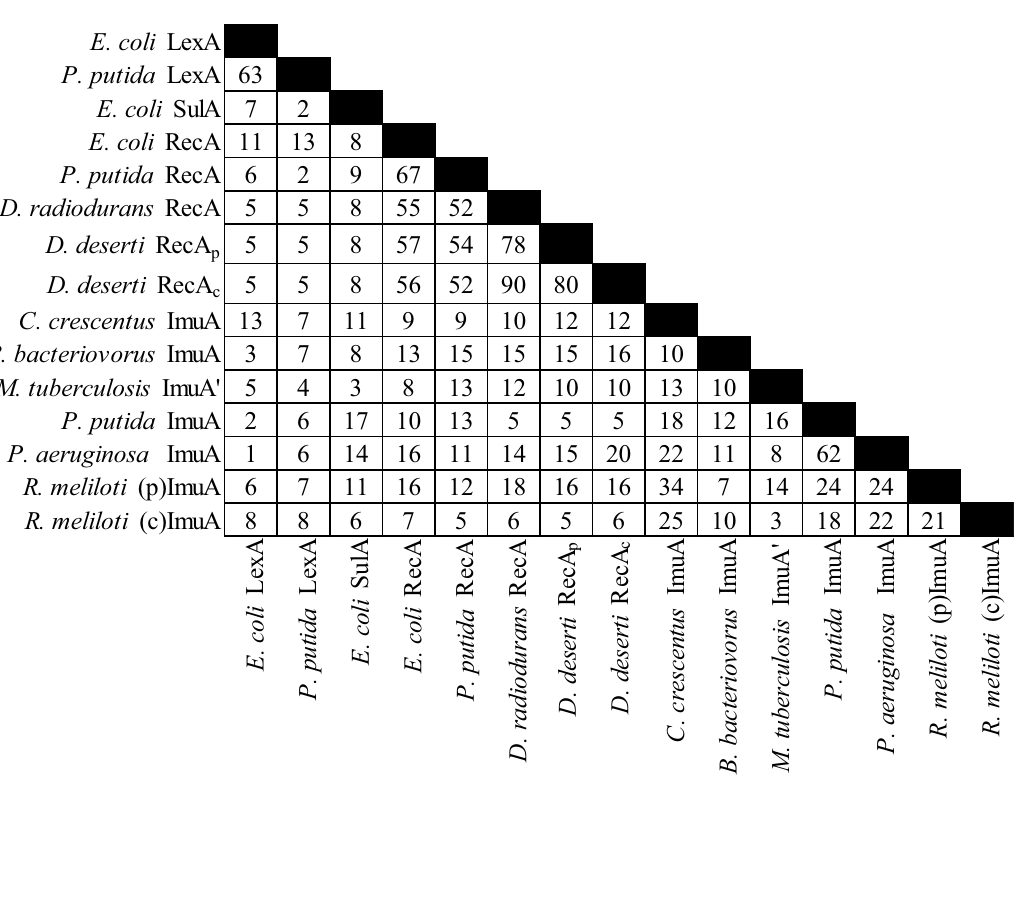
Figure 2. Percent identities by ClustalW2 [213,214] for the ImuA protein and related (cid:83)(cid:85)(cid:82)(cid:87)(cid:72)(cid:76)(cid:81)(cid:86)(cid:17)(cid:3)(cid:179)(cid:11)(cid:83)(cid:12)(cid:180)(cid:3)(cid:85)(cid:72)(cid:83)(cid:85)(cid:72)(cid:86)(cid:72)(cid:81)(cid:87)(cid:86)(cid:3)(cid:87)(cid:75)(cid:72)(cid:3)(cid:83)(cid:79)(cid:68)(cid:86)(cid:80)(cid:76)(cid:71)(cid:3)(cid:74)(cid:72)(cid:81)(cid:72)(cid:3)(cid:83)(cid:85)(cid:82)(cid:71)(cid:88)(cid:70)(cid:87)(cid:15)(cid:3)(cid:179)(cid:11)(cid:70)(cid:12)(cid:180)(cid:3)(cid:85)(cid:72)(cid:83)(cid:85)(cid:72)(cid:86)(cid:72)(cid:81)(cid:87)(cid:86)(cid:3)(cid:87)(cid:75)(cid:72)(cid:3)(cid:70)(cid:75)(cid:85)(cid:82)(cid:80)(cid:82)(cid:86)(cid:82)(cid:80)(cid:68)(cid:79)(cid:3)(cid:74)(cid:72)(cid:81)(cid:72)(cid:3) product. The accessions are from Uniprot [215], from left to right: P0A7C2, P0A154, P0AFZ5, P0A7G6, Q07447, P42443, C1D2C5, C1CXY5, C1D2K8, Q9A3J1, Q6MQS4, Q50730, Q88I84, Q9I5Q0, Q92ZJ8,